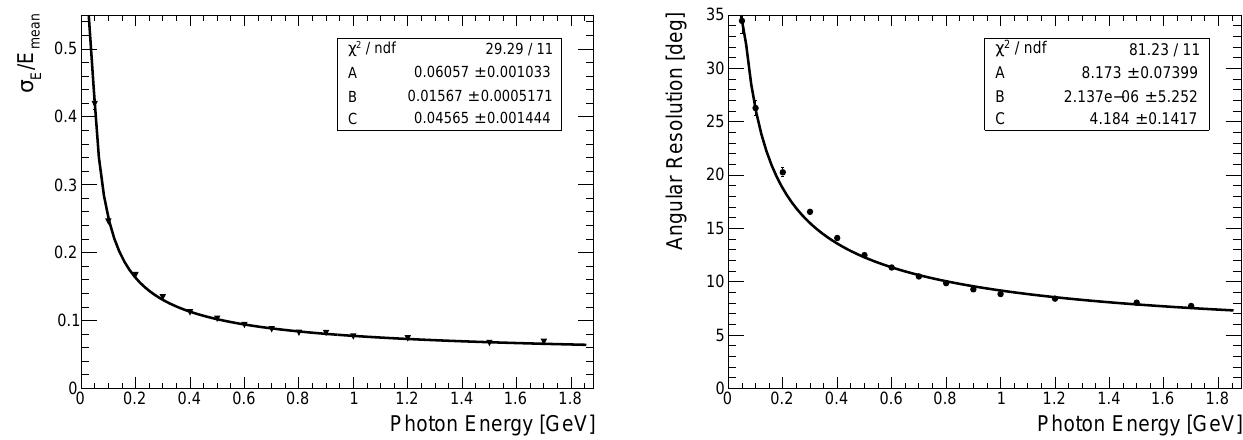
Figure 74. ( Left ): The energy resolution in the barrel as a function of the true photon energy. The energy resolution is determined by a Gaussian fit to the visible energy. ( Right ): The angular resolution in the barrel as a function of the true photon energy. The angular resolution is determined by a Gaussian fit to the 68% quantile distribution. The fit function is of B = A C . the form σ E E E ⊕ √ E ⊕